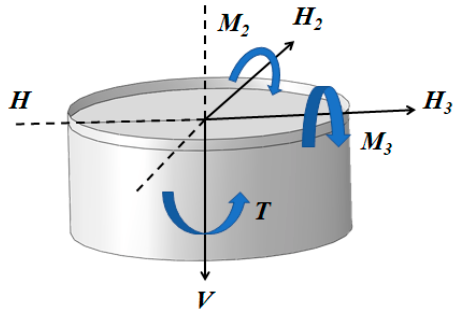
Figure 2. Composite loading schematic diagram.